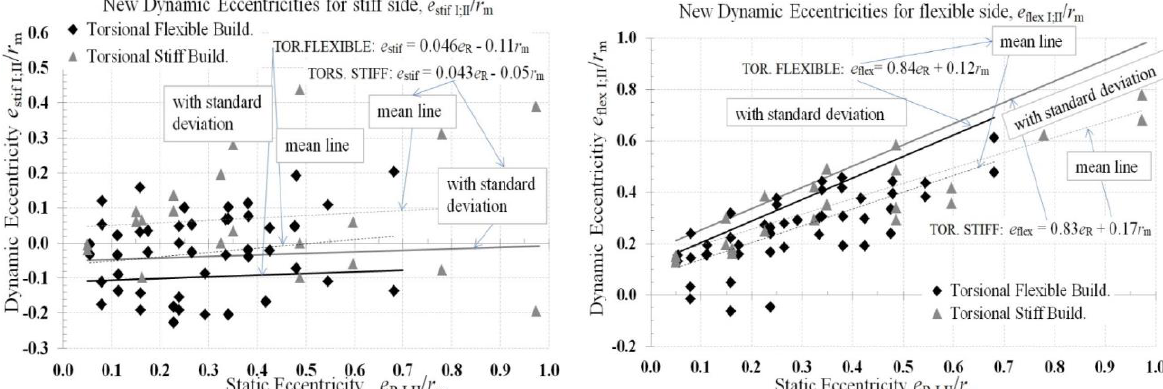
⁄ for the stiff side, right: 𝑒 𝑟 stif I;II m flexible